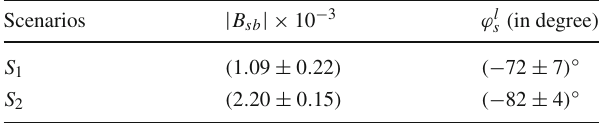
Table 1 Numerical values of coupling parameters Scenarios